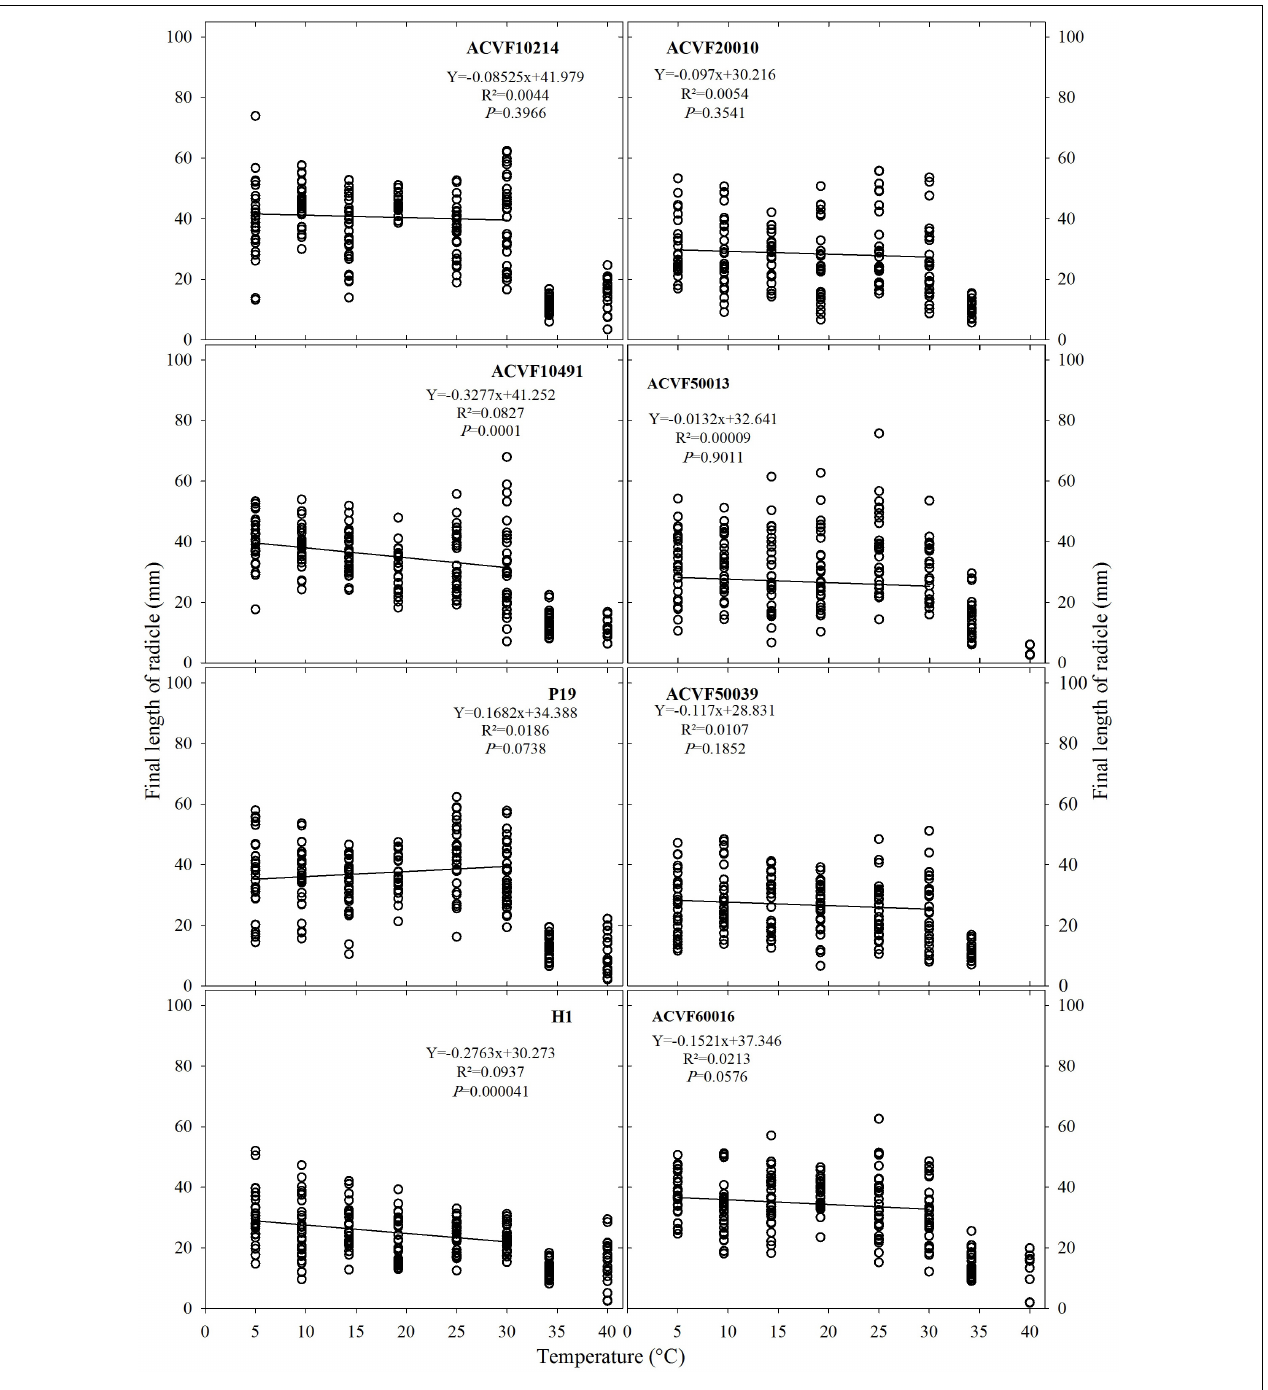
FIGURE 5 | Final length of radicle for the accessions of Lolium perenne during heterotrophic growth in response to a constant temperature. For each temperature between 5 and 35 ◦ C, n = 30. For 40 ◦ C, 0 ≤ n ≤ 30 because of seedling